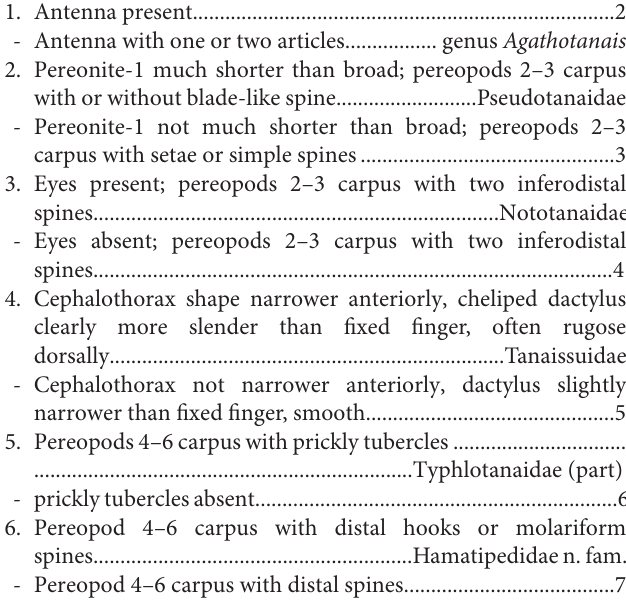
Key for identification of Paratanaoidea with three-articled antennule (neuters) and uropod endopod with one or two articles